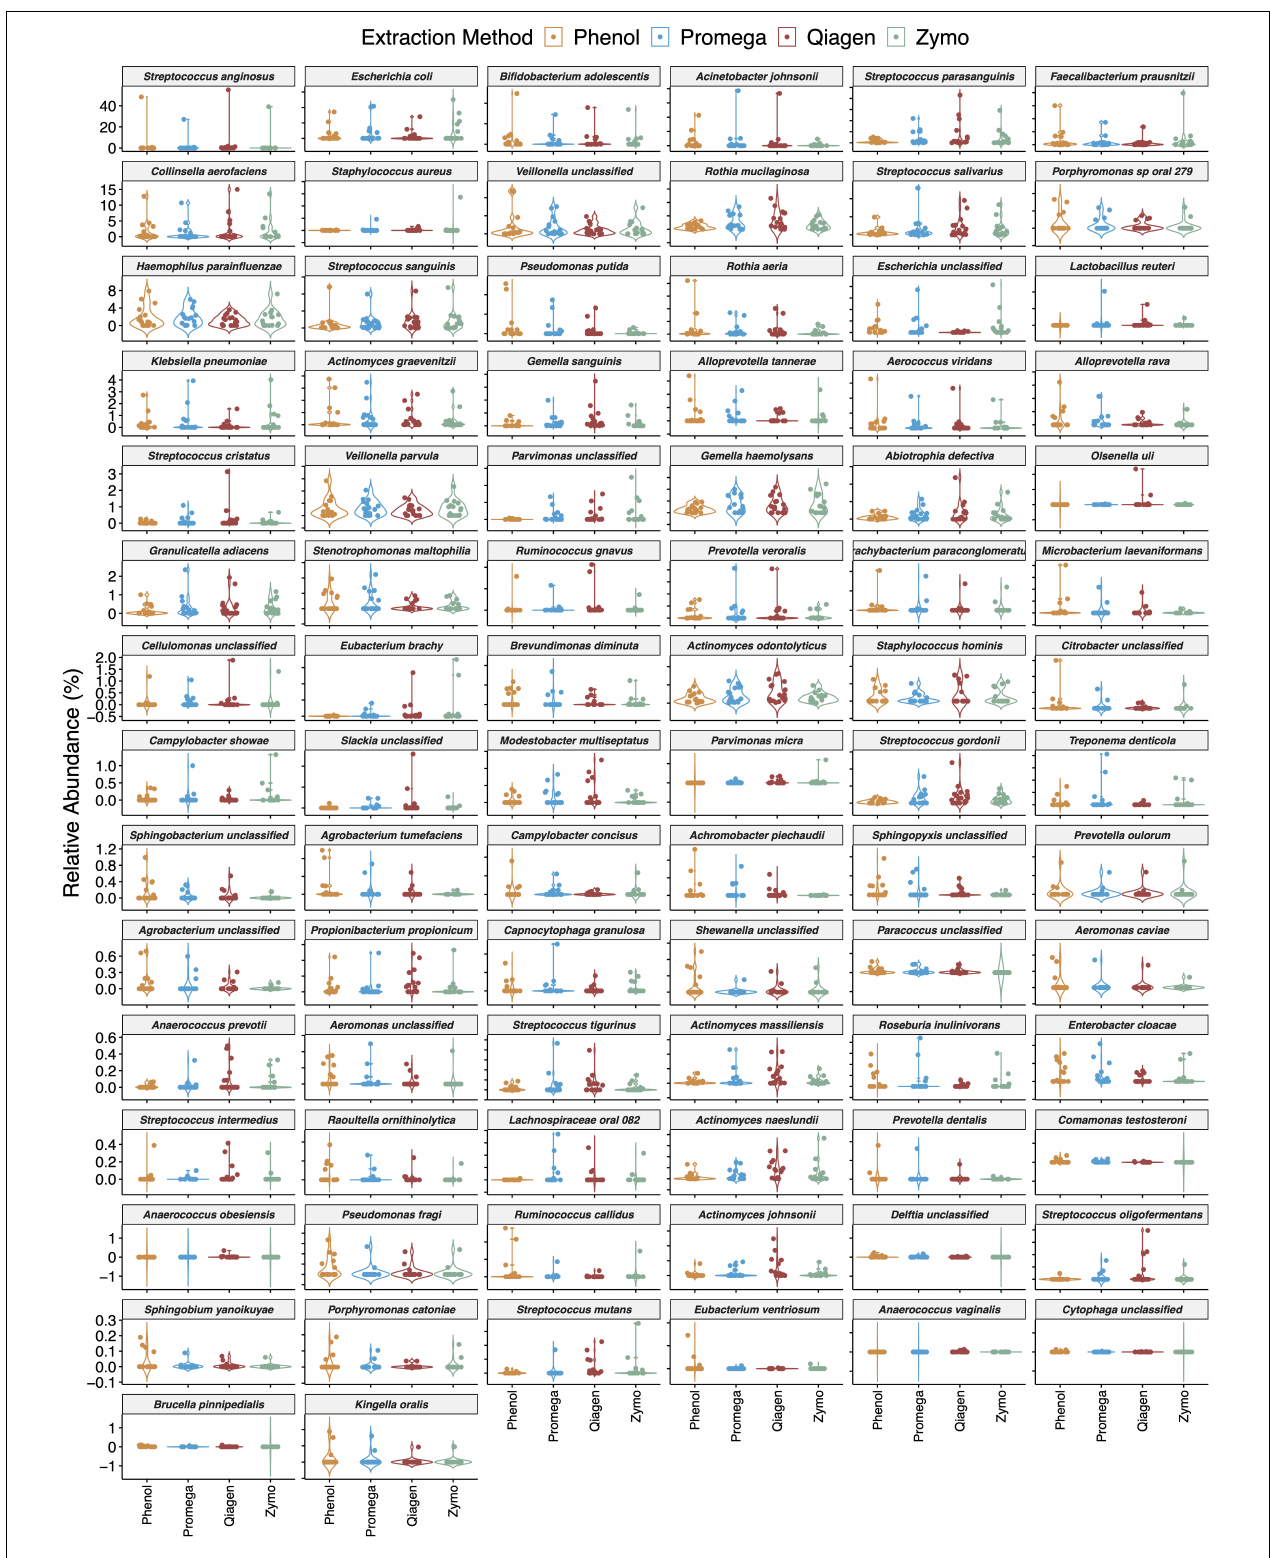
FIGURE 6 | Impact of extraction method on differential abundance of microbiota. Boosted general linear models were performed on centered log-ratio transformed abundance and identified 86 microbial species with 113 pairwise comparisons that were differentially abundant based on extraction method. Here violin plots are sorted by decreasing relative abundance, and therefore the y-axis scale differs in each